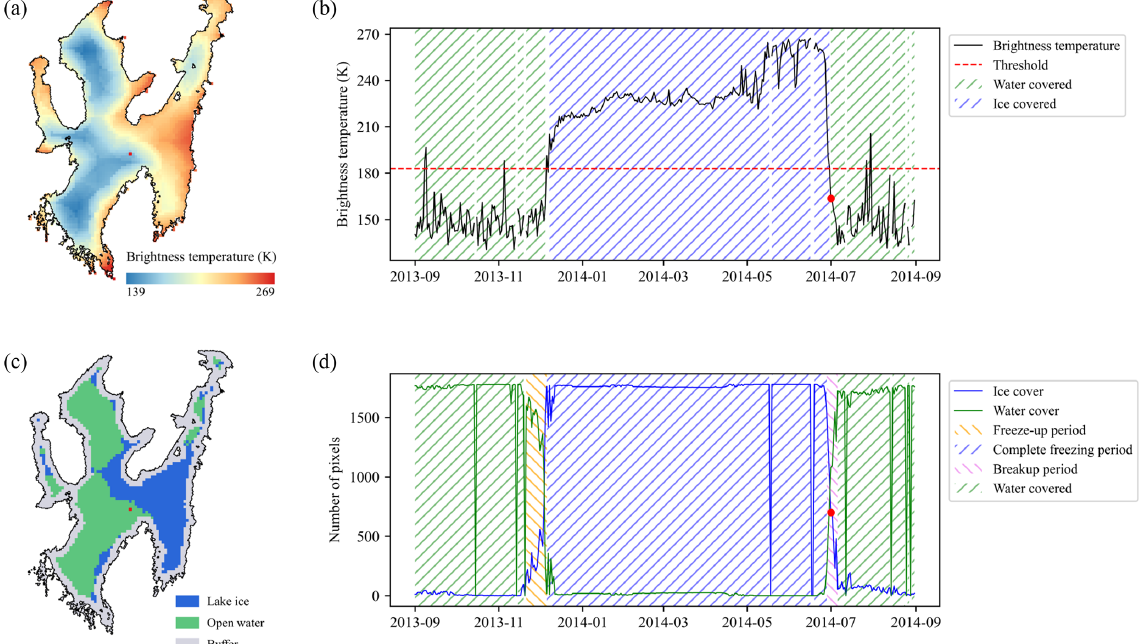
Figure 2. Example of determining the lake ice status for a pixel and extracting the ice phenology for a lake. Panel (a) shows the T B image of Great Bear Lake on 1 July 2014. Panel (b) presents the variations in the T B for the pixel marked in red in panel (a) ; the red line represents the reference T B determined by the MTT algorithm, and the pixel was determined to be water covered on 1 July 2014 (red dot). Panel (c) is the lake ice status for all of the pixels at least 6.25km away from the lake shore on 1 July 2014. Panel (d) shows variations in the number of lake ice and open water pixels for Great Bear Lake in 2014; the lake ice phenology was extracted using thresholds of 5% and 95% of the total lake pixels, and 1 July 2014 (red dot on the ice cover line) was determined to be in the breakup